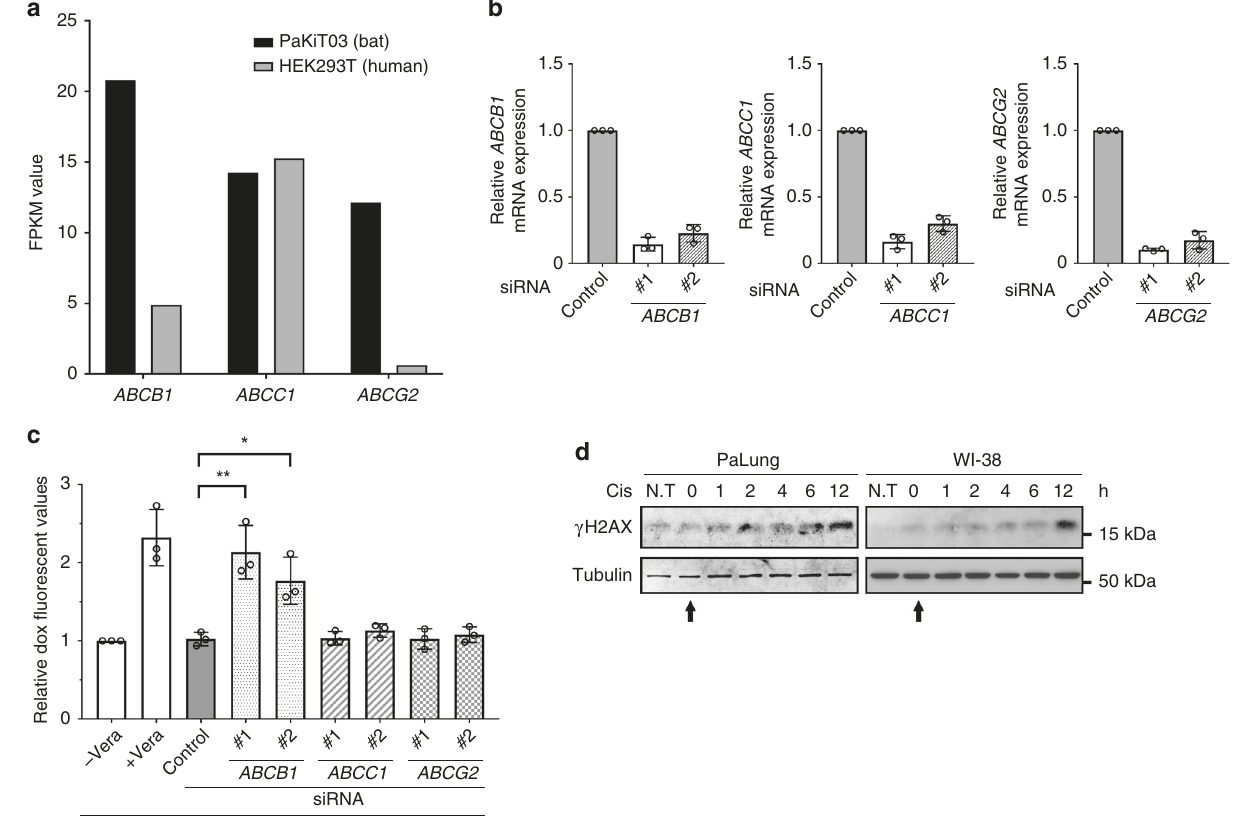
Fig. 5 Identi fi cation of ABCB1 for the intrinsic doxorubicin ef fl ux capability in bat cells. a Relative mRNA expression levels of ABCB1 , ABCC1 and ABCG2 in human HEK293T and P. alecto kidney immortalised (PaKiT03) cell lines are shown by FPKM values. b qRT-PCR to determine the knockdown ef fi ciency of each ABC transporter. PaKiT03 cells were transfected with control or two independent siRNAs of the indicated genes. mRNA expression of each gene is normalised to GAPDH mRNA expression, and presented relative to the control siRNA sample (mean ± SD from three experiments). c Doxorubicin (Dox) accumulation in PaKiT03 cells after siRNA knockdown of ABCB1 , ABCC1 and ABCG2 . Cells were treated with 10 µ M doxorubicin for 3 h and analysed by fl ow cytometry. Verapamil (Vera) was used as a positive control for ABC transporter inhibition. Control represents the cells transfected with control siRNA.